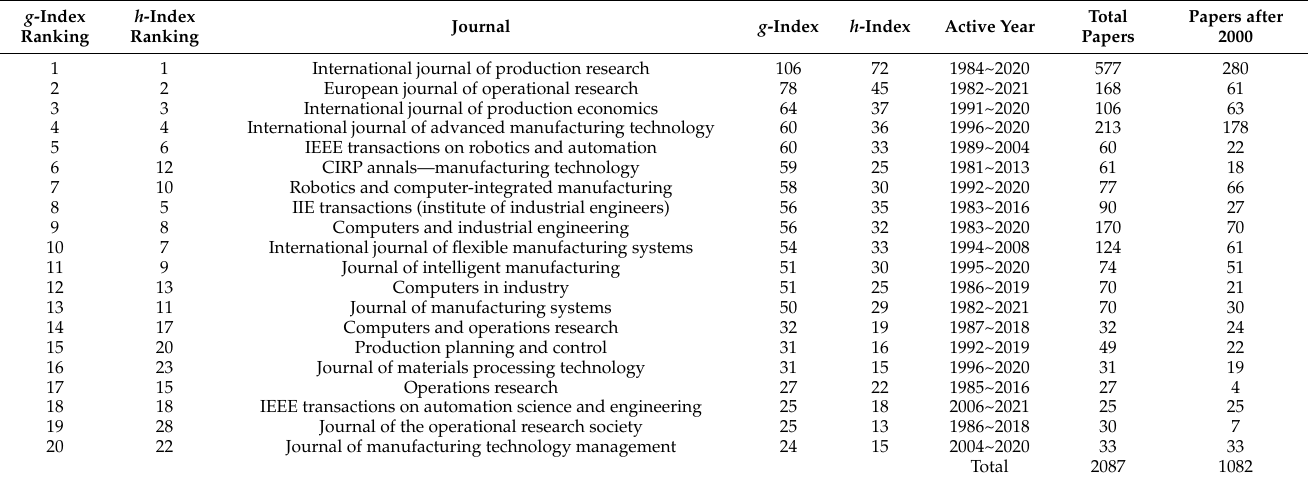
Table 1. Top 20 journals on FMS